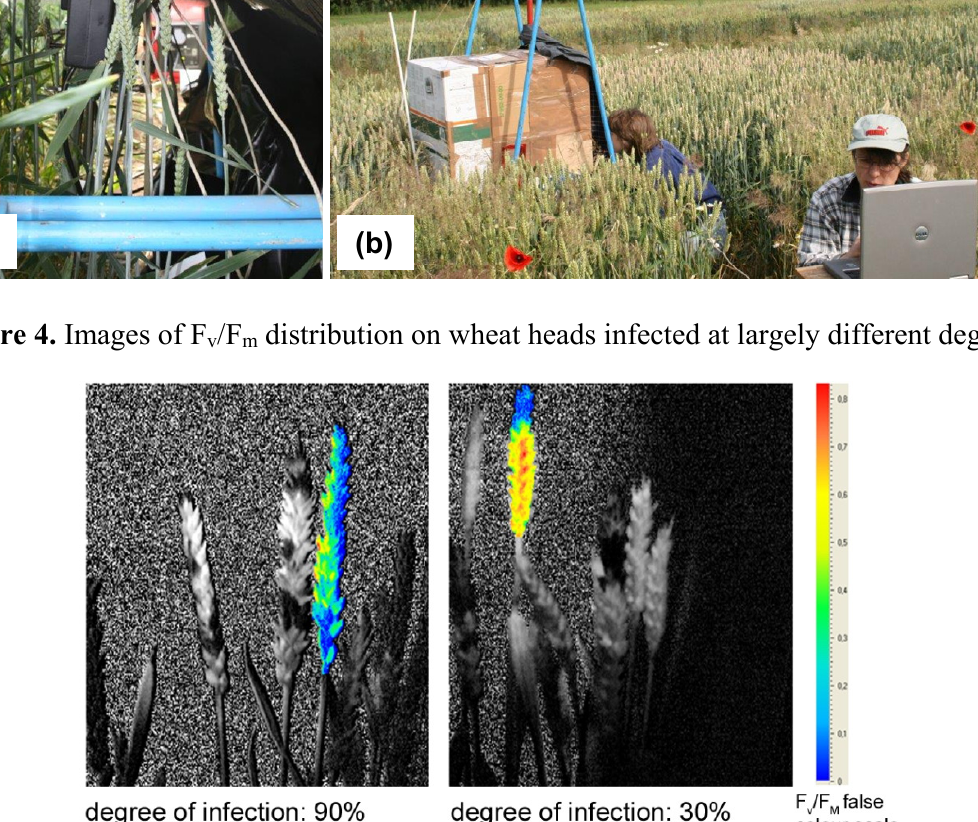
Figure 3. CFI measurements for on-field evaluation of Fusarium infection in wheat: